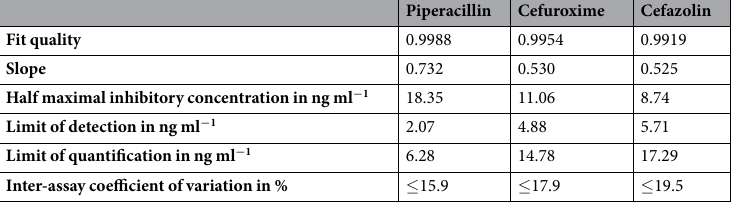
Table 1. Parameters of the antibiotic assays, obtained from the 4-parametric fit of the respective calibration curve.